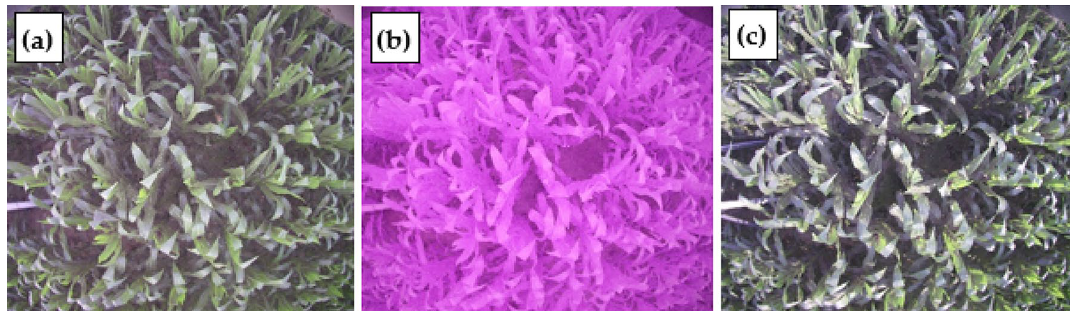
Figure 3. Three images on July 2 of site 1: ( a ) and ( c ) are true-color images obtained at 05:31 a.m. and 6:32 p.m., and ( b ) is a false-color image when the blue filter is removed at 1:28